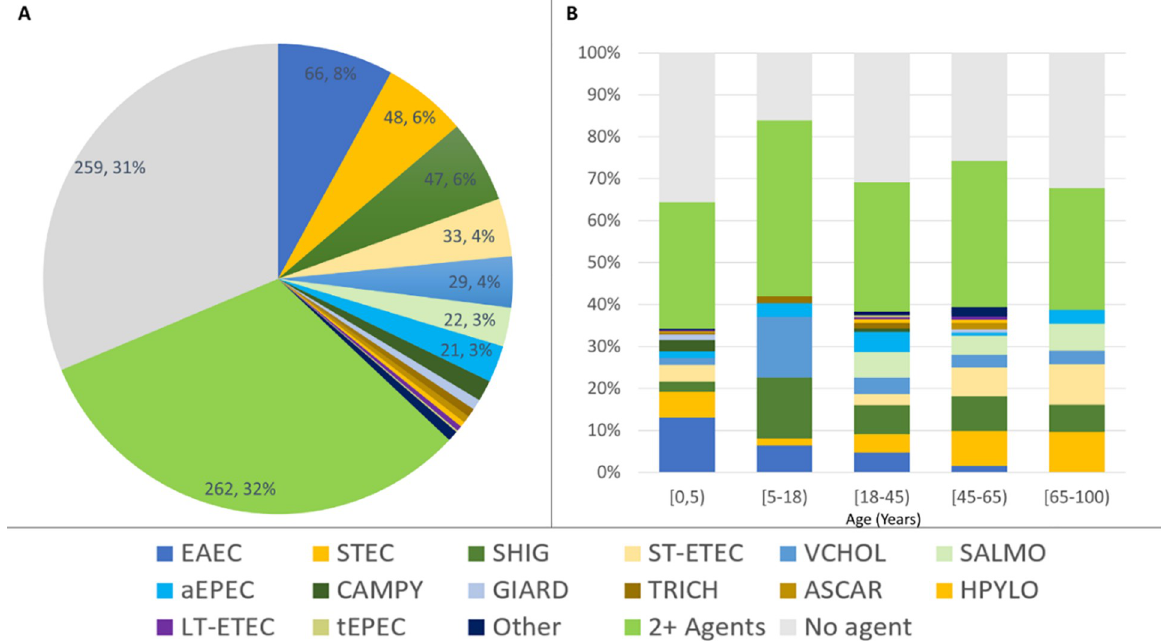
Fig 3. Distribution of single-and multi-pathogen infections among hospitalized patients with diarrheal disease. Distributions are presented as an aggregate (A) or stratified by age group (B) . The percentages are based on the total number of samples in which a stool sample was tested (n = 827). Pathogens under 1 percent are grouped as ‘other’. Abbreviations are defined in Fig 2.